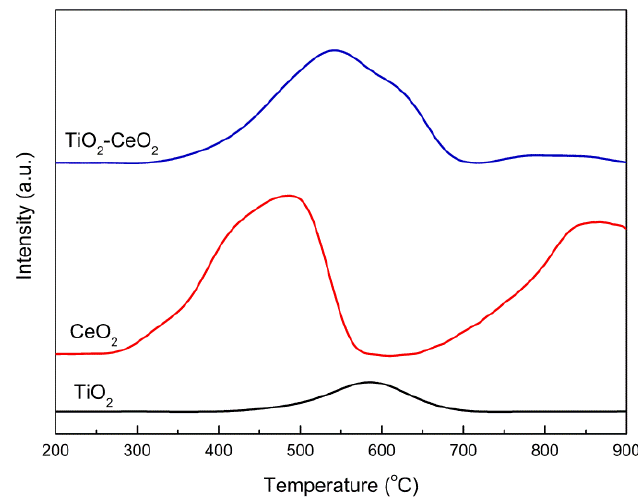
Figure 7. H 2 -TPR profiles of the CeO 2 , TiO 2 and TiO 2 -CeO 2 catalysts.